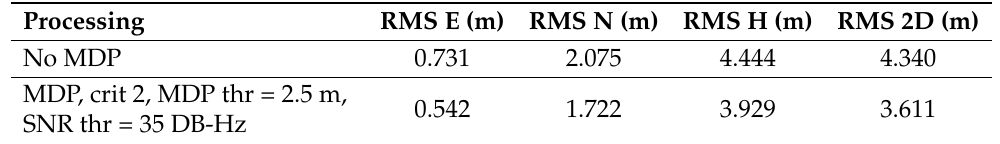
Table 8. RMS obtained for criterion 2, MDP static